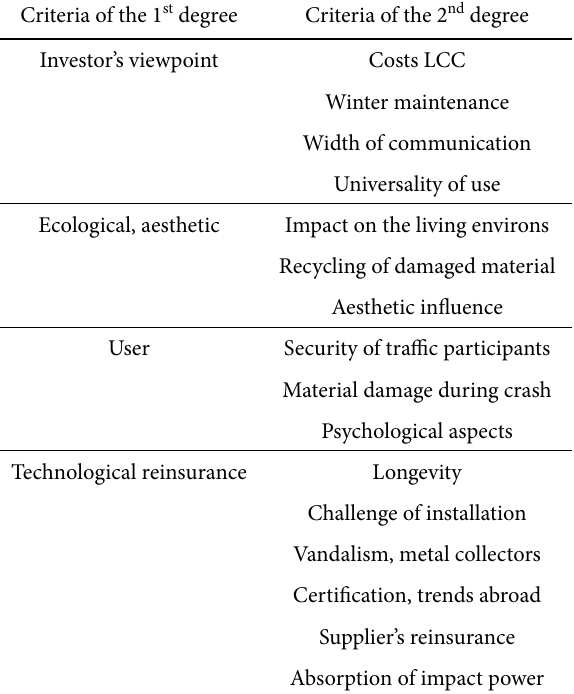
Table 1. Criteria tree of